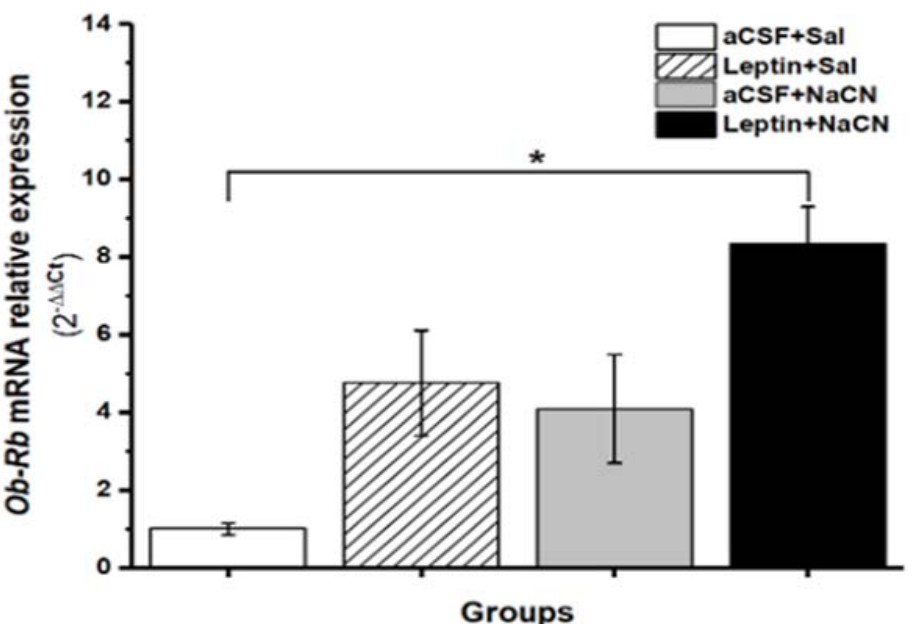
Figure 4. Relative expression of leptin Ob-Rb mRNA receptors in control (aCSF + Sal), or following leptin in cNTS (leptin + Sal), NaCN in the ICS (aCSF + NaCN), or both leptin in cNTS and NaCN in the ICS (leptin + NaCN). The values are means ± SDM. * p = 0.03. ANOVA with Scheffé post hoc test. aCSF, artificial cerebrospinal fluid; cNTS, commissural nucleus tractus solitarius; isolated ca- rotid sinus (IC); NaCN, sodium cyanide; Sal, saline.